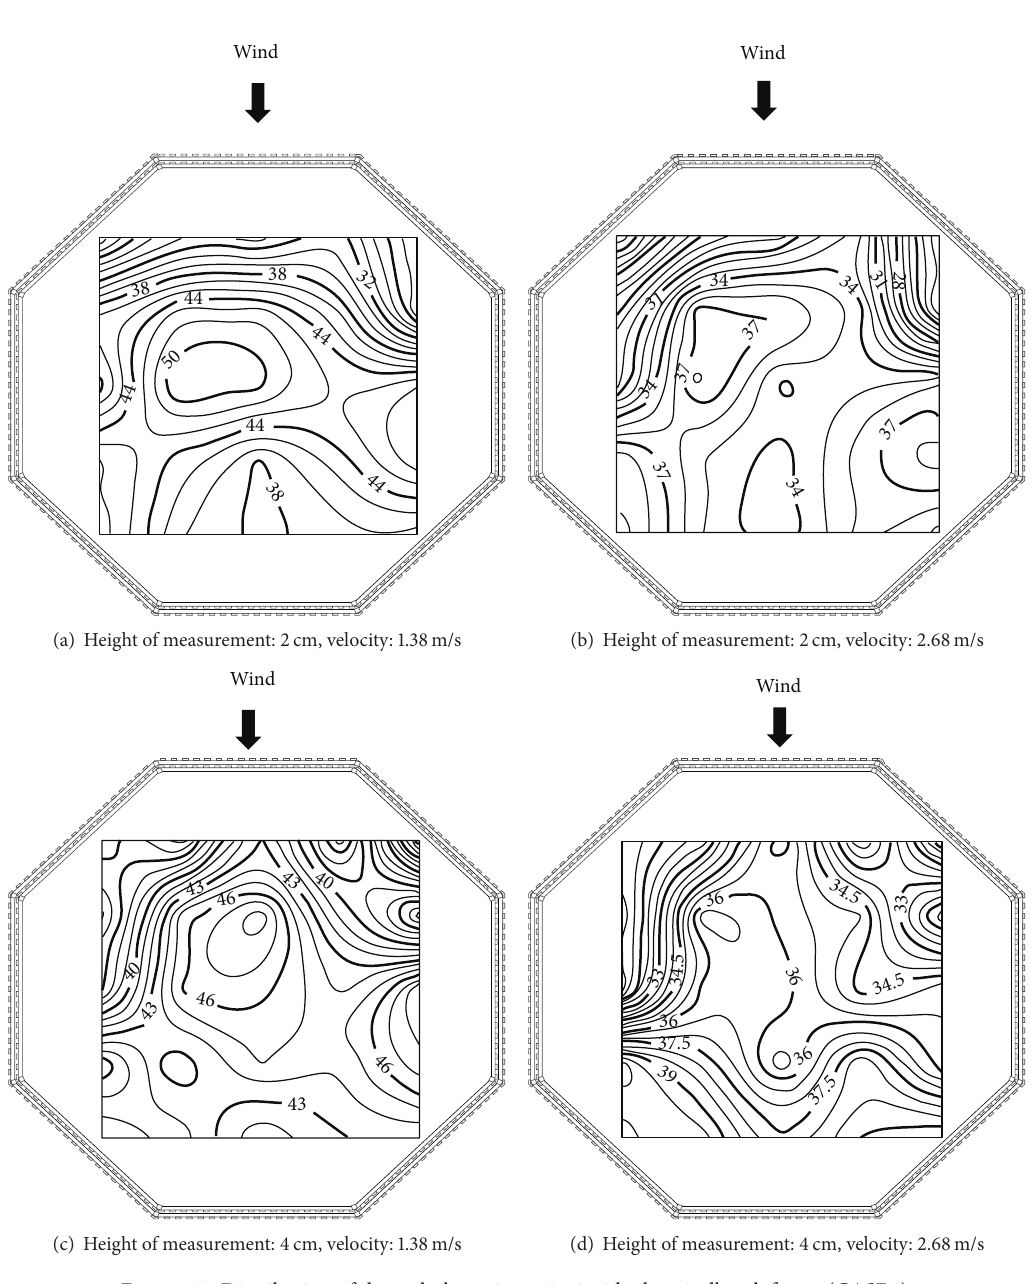
Figure 19: Distribution of the turbulence intensity inside the windbreak fence. (CASE 1).